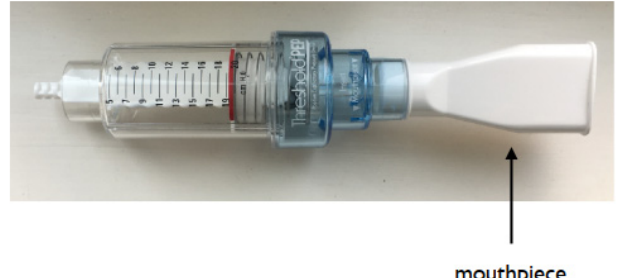
Figure 5. An example of EMST device (Threshold PEP) . The subjects are asked to open their mouth following maximum inhalation and place the mouthpiece between the lips.